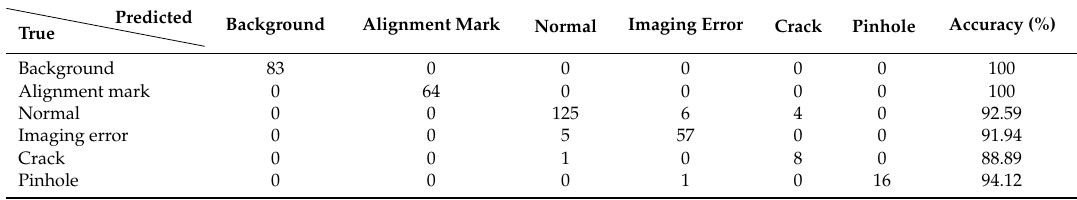
Table 10. Confusion matrix for additional 370 test data: six-class classification